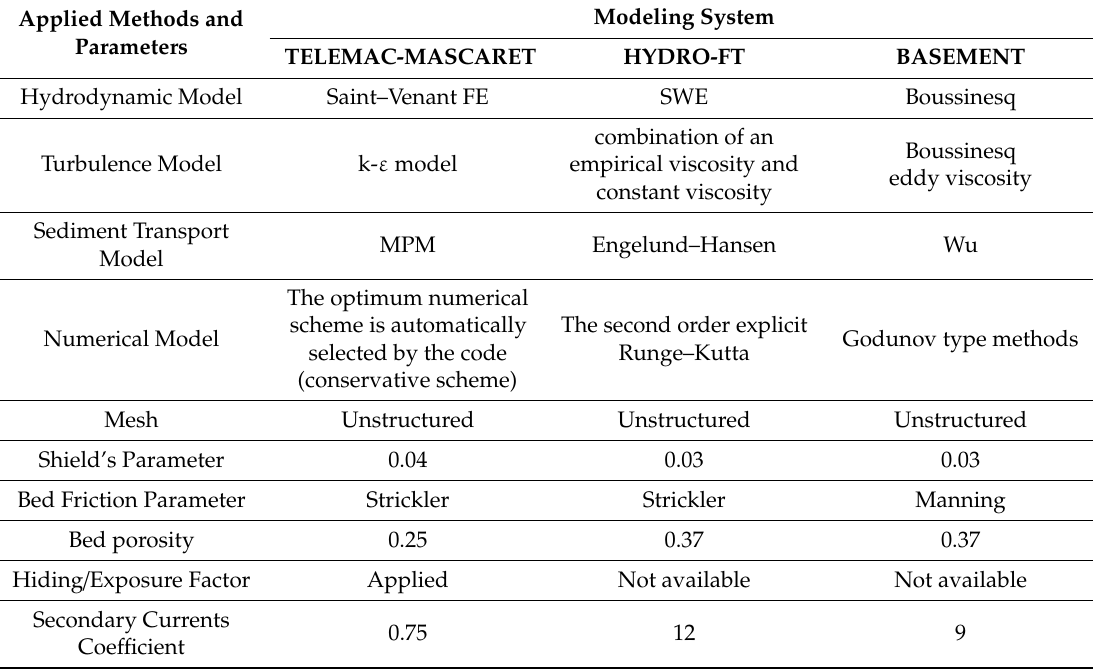
Table 3. Comparison of parameters utilized for each model